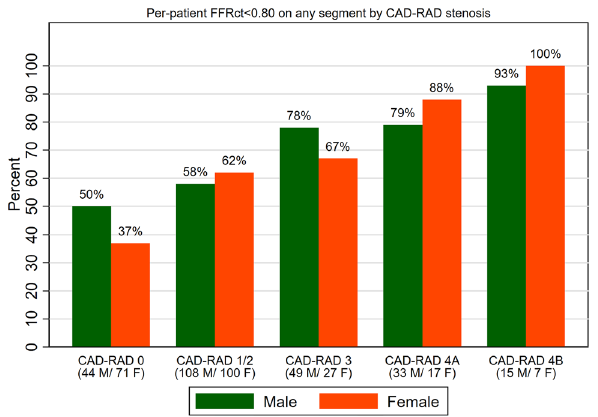
Figure 2. Prevalence of FFR CT < 0.8 in any segment per patient and for each coronary vessel stratified by sex and CAD-RAD score. FFR